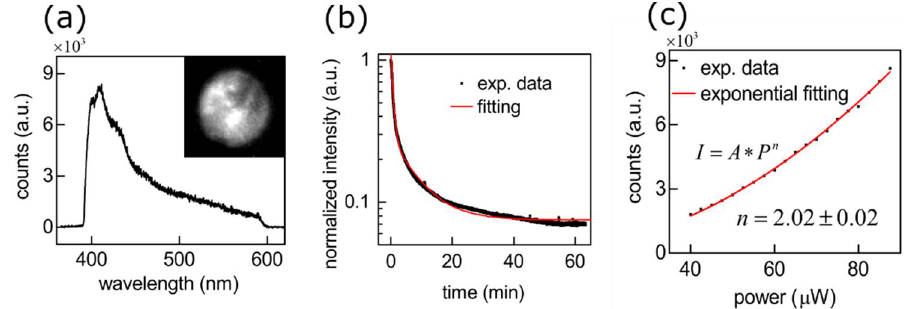
Figure 5. Fluorescence data from MEH-PPP microspheres. ( a ) Two-photon fluorescence spectrum from a single microsphere. The inset shows an TPF image captured by a monochrome camera (diameter of the microsphere is ~15.0 µ m). ( b ) The normalized fluorescence intensity of a single microsphere as a function of time at an excitation power of 2 mW. The red curve represents a double exponential fitting using Equation (S2). ( c ) Two-photon fluorescence intensity as a function of the incident laser power. The red curve shows a power law fit which yielded an exponent of 2.02 ± 0.02.